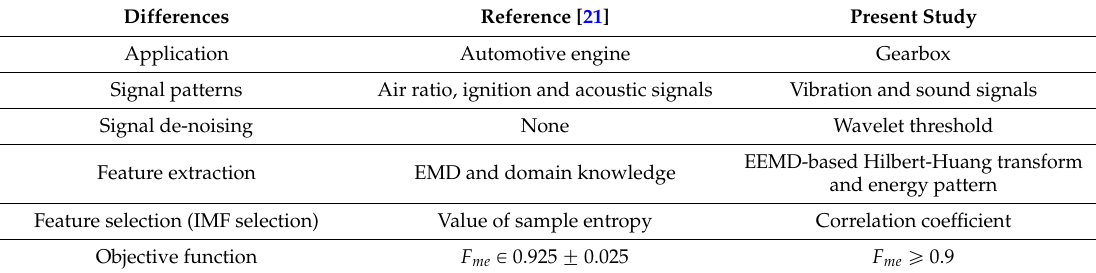
Table 1. Differences of diagnostic framework between reference [21] and this study.